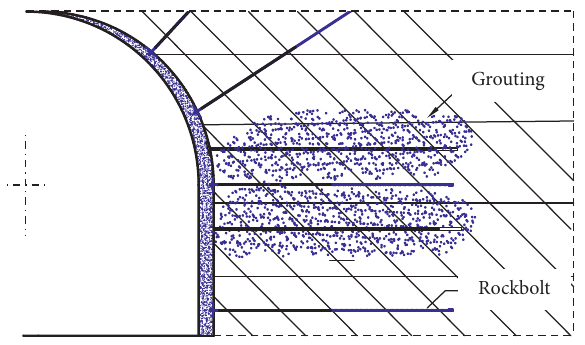
Figure 19: Schematic diagram of the support system.